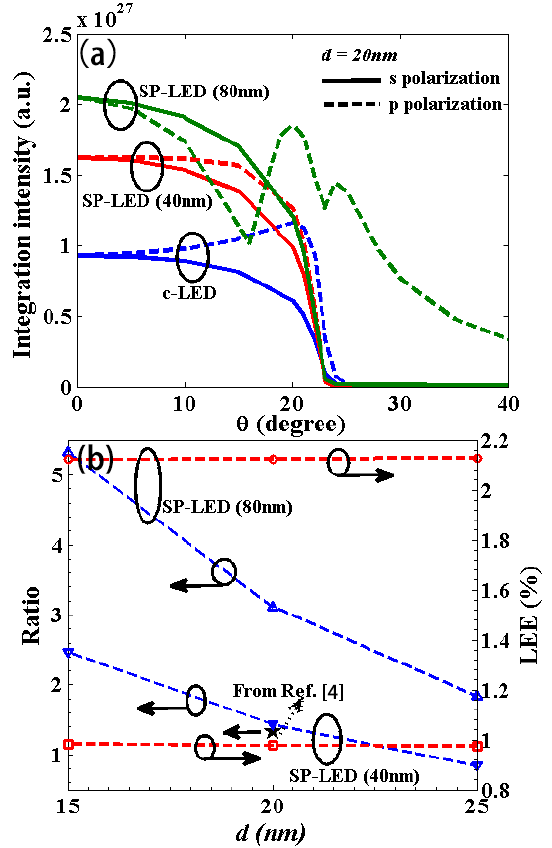
Figure 5. ( a ) The integrated intensity I( θ ) of the output spectrum with s- and p-polarizations as a function of θ for c-LED and SP-LED, and ( b ) the ratio of luminous efficiency of both SP-LED and c-LED and the light extraction efficiency (LEE) of SP-LED as a function of the Al-QW coupling distance d . The asterisk in the figure is the experimental value from the literature [4].